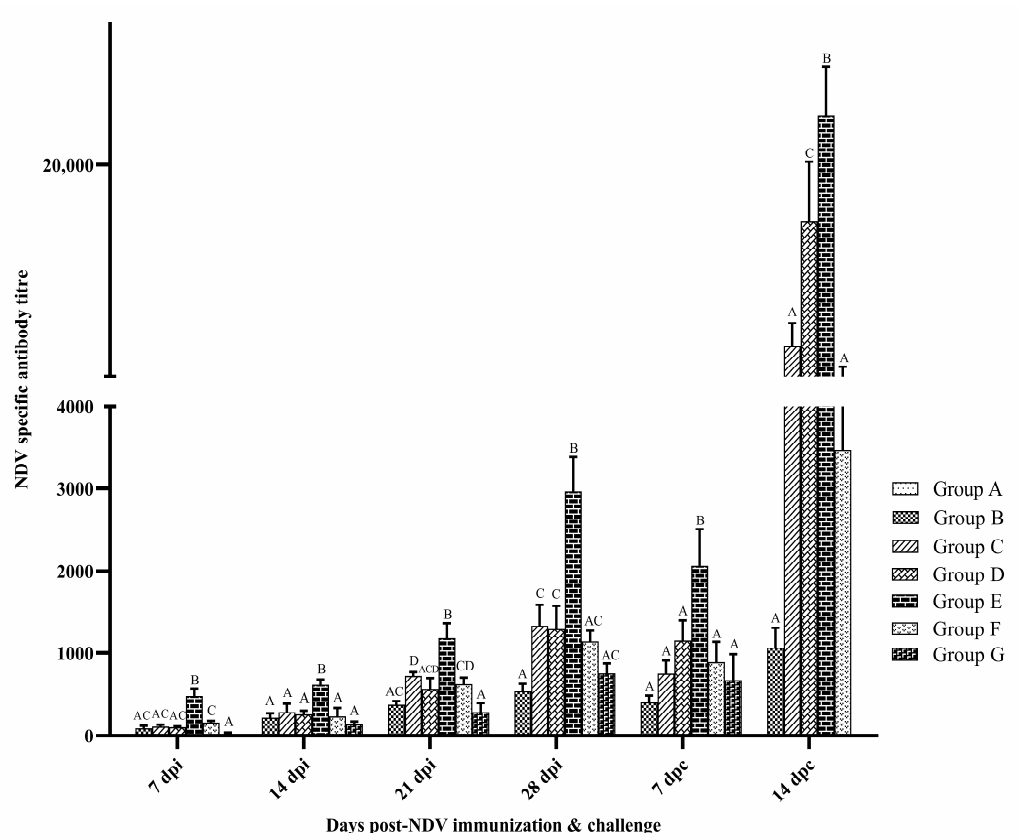
Figure 2. NDV-specific antibody titers in SPF chicken following immunization and challenge. Treatment effect was analyzed at each time point by two-way ANOVA with Tukey’s test as the post hoc test. The probability of an alpha error was set at 0.05. Different superscripts above bars (mean ± SE) indicate significant difference between groups ( p < 0.05). dpi: days post-NDV immunization.